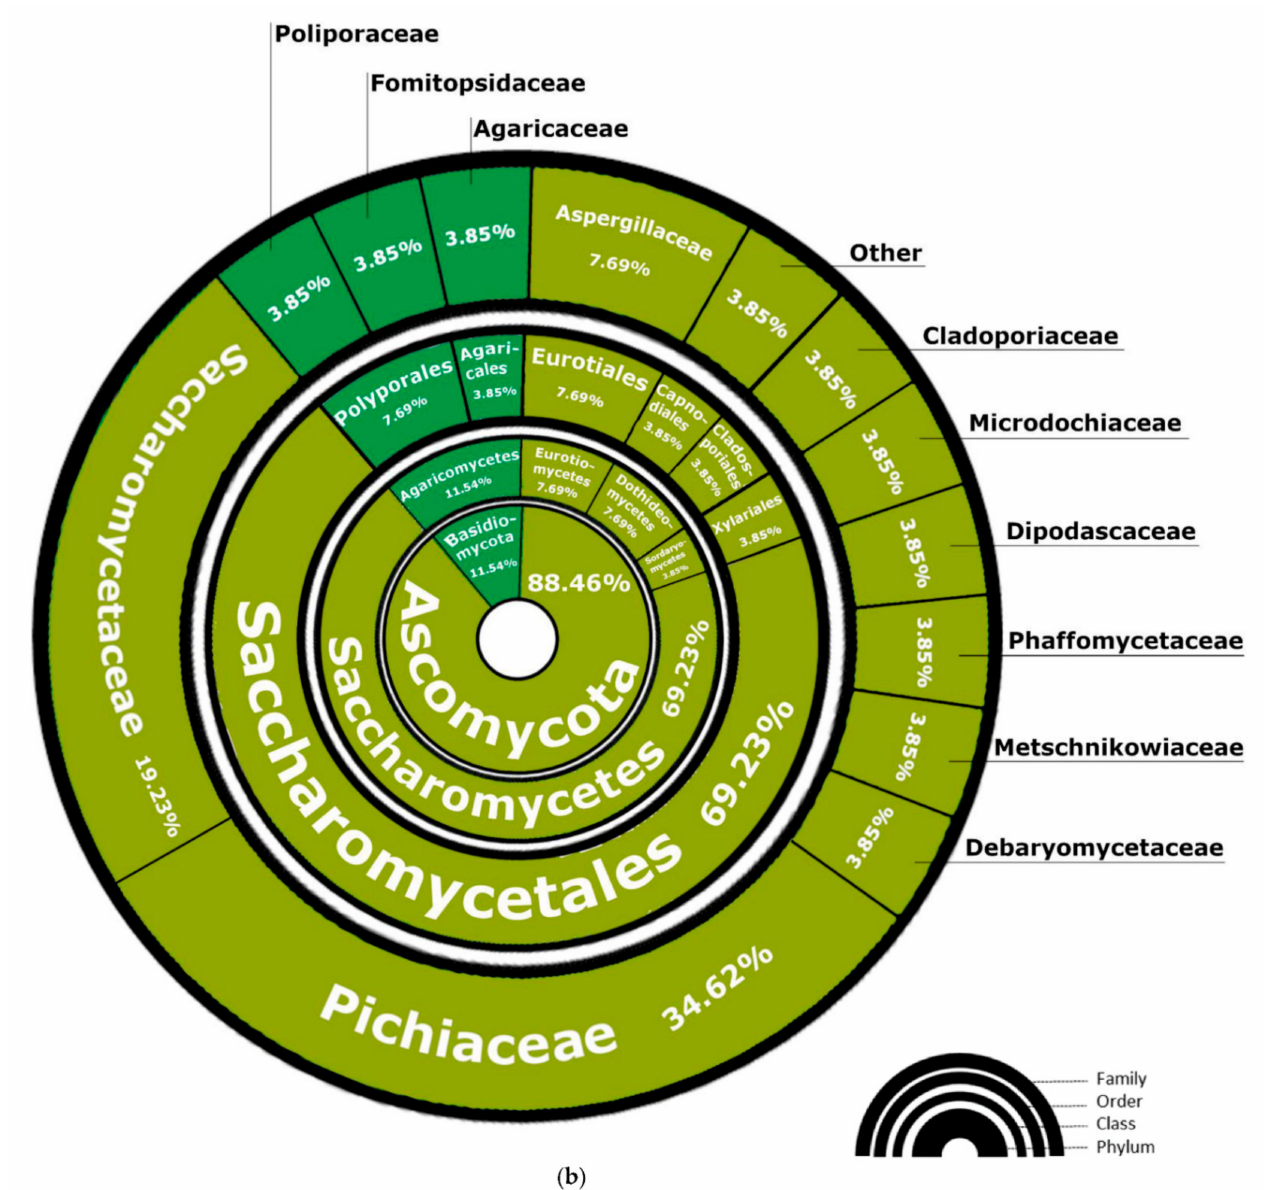
Figure 7. Phylogenetic analysis and abundance of fungal taxa. ( a ) Phylogenetic tree constructed based on the ASVs of 26 fungal species found in the mixed-fermentation beer samples. Supplementary Information File S3 contains a high- resolution version of Figure 7a, suitable for zooming and enlargement. ( b ) The image shows the prevalence of taxonomic classifications according to genera and species found in the fungal microbiomes. Higher taxonomic classifications are shown in circles near the image center, while lower classifications are shown toward the outer